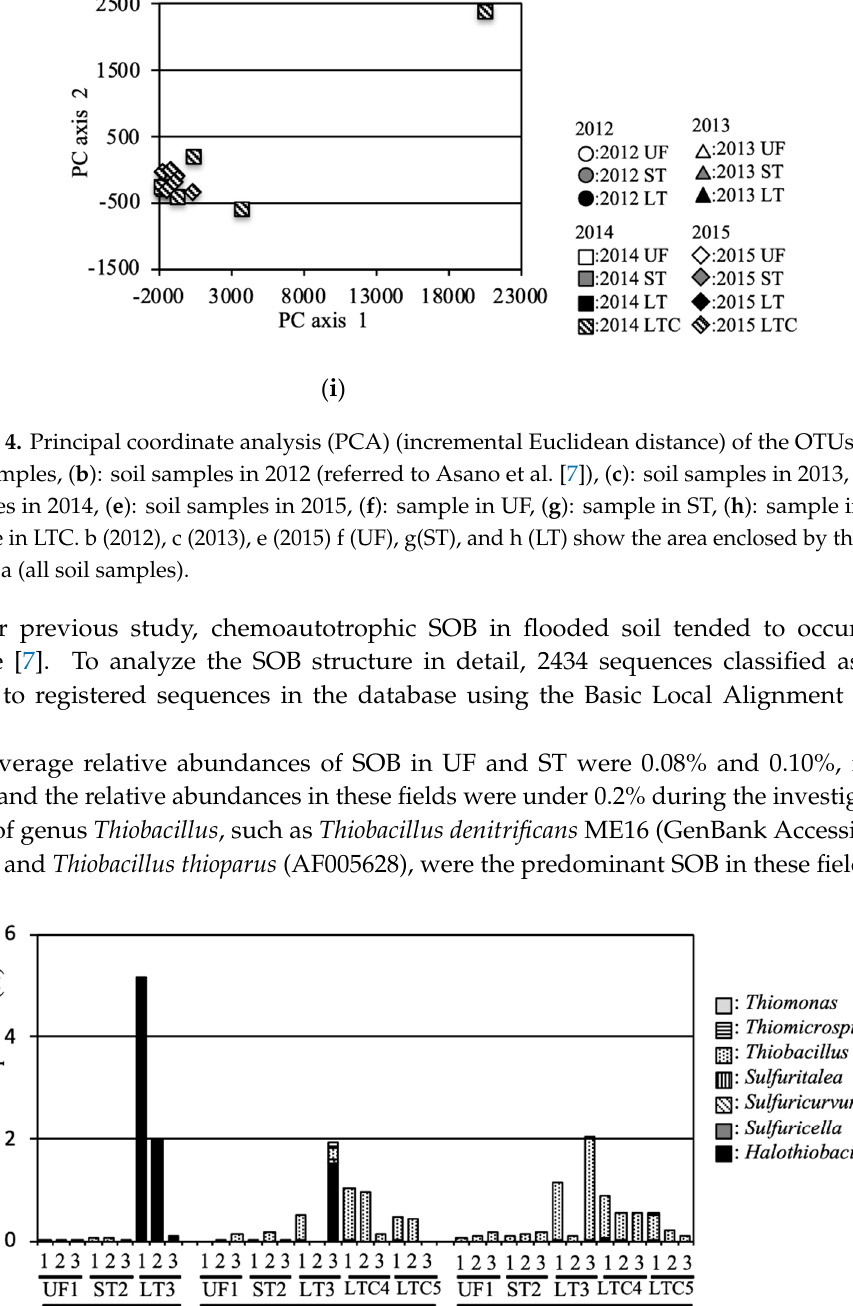
Figure 6. Relative abundance of the nitrite-oxidizing bacteria (NOB) in the soil samples. 3.5. Bacterial Communities in Marine Materials To compare with the bacterial communities in inundated soil, marine environment bacterial communities were also analyzed. The phyla Proteobacteria and Bacteroidetes were predominant in all marine samples (Figure 7). With regards to the subgroups of Proteobacteria, the delta, gamma, and alpha subgroups were consistently predominant in BYS, SS and SW, respectively. The zeta subgroup was consistently detected in BYS (0.5% and 0.9% in 2014 and 2015, respectively). SOB such as those in the genera Thiobacillus , Sulfurimonas and Sulfuricurvum were consistently detected in BYS.